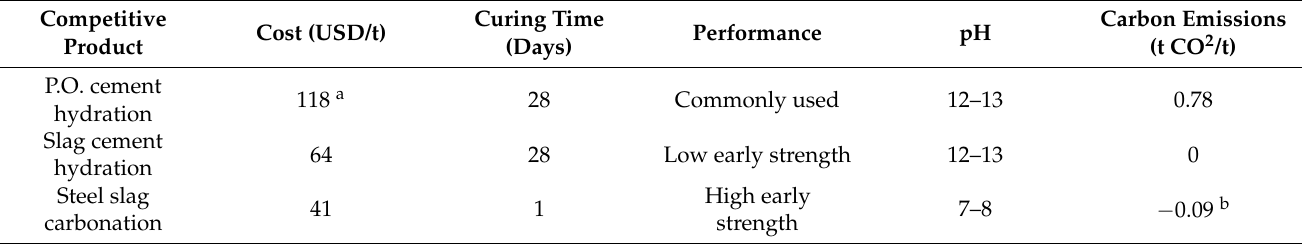
Table 1. Comparative product analysis of competitive